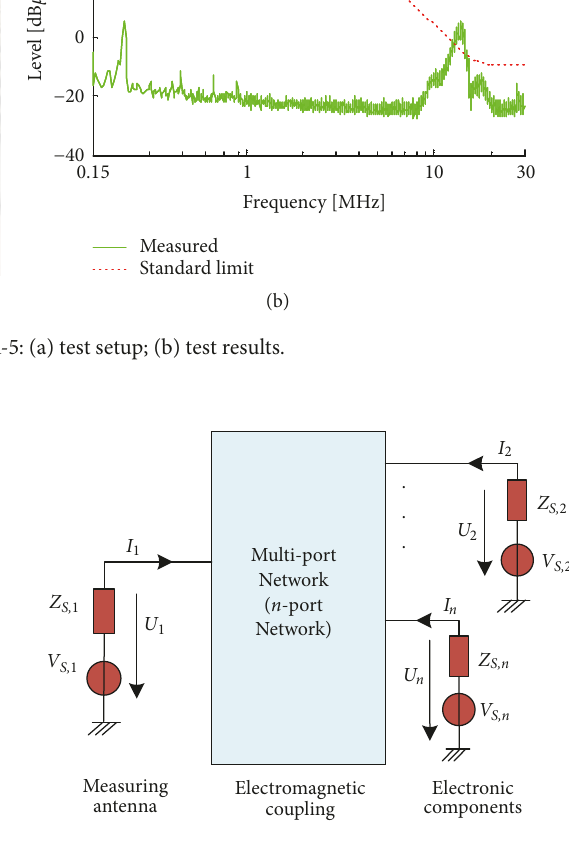
Figure 2: Model for pre-vehicle-level radiated EMI.